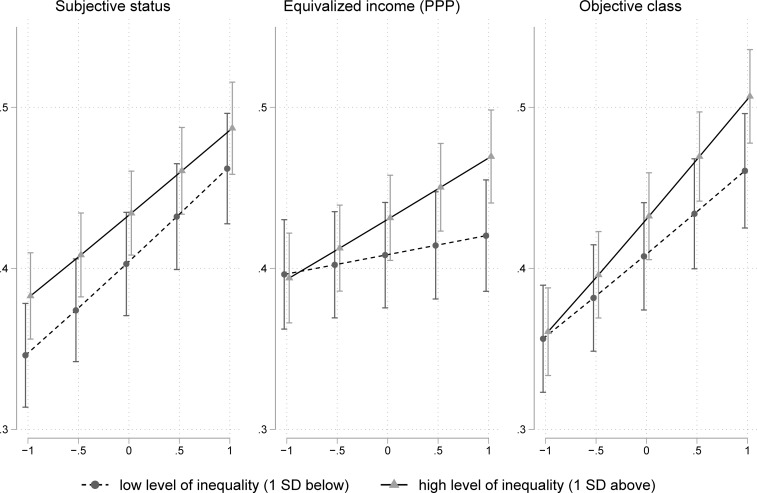
Predicted probabilities of volunteering derived from the models in Table 6.